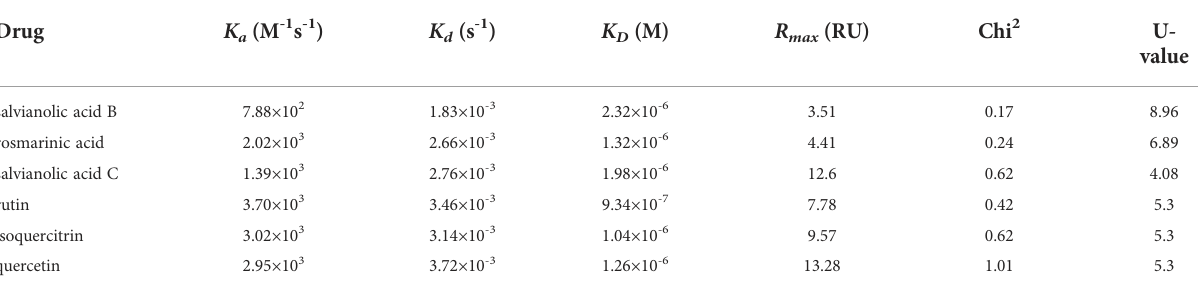
TABLE 3 Kinetic parameters of drugs with ER b